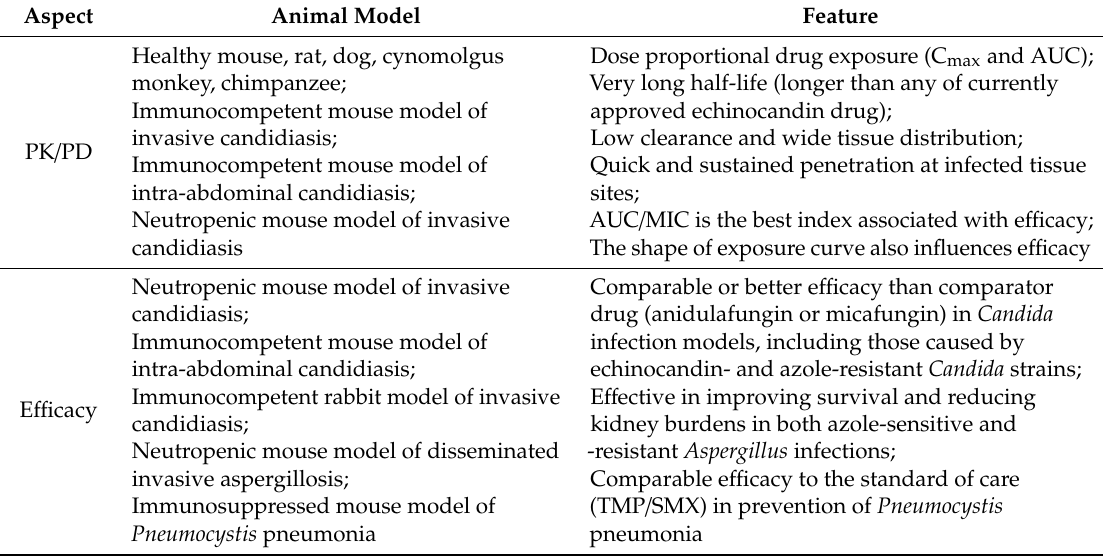
Table 1. In vivo characterization of rezafungin.